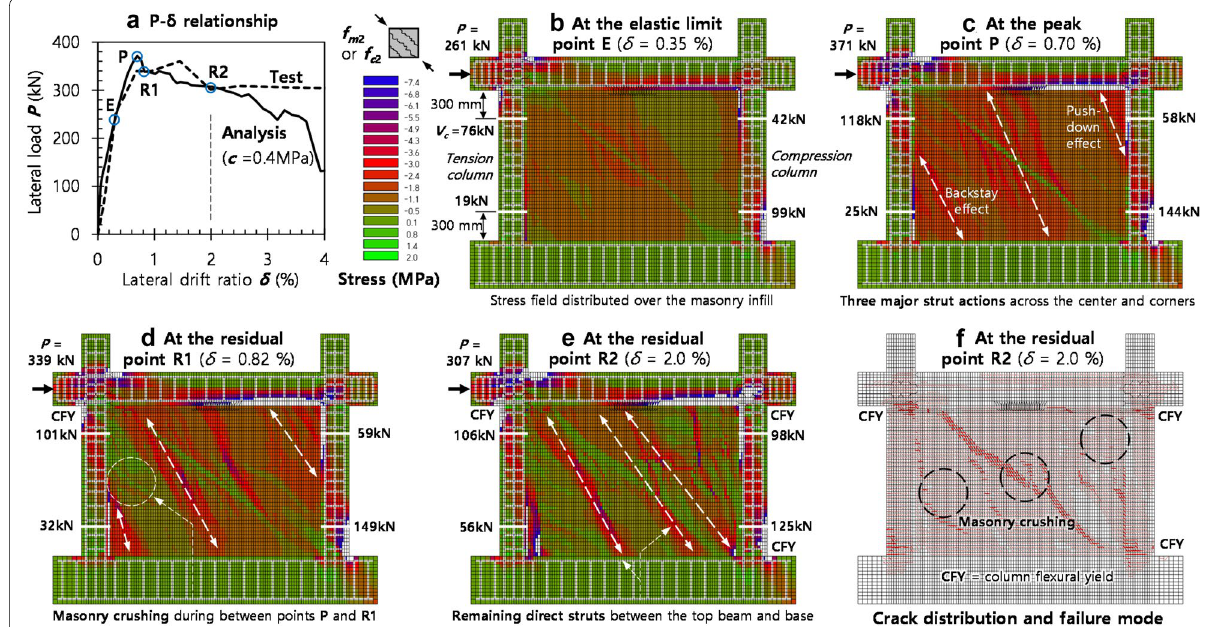
Fig. 6 Variation of stress distribution and force transfer with deformation: standard infilled frame IF0.5–weak masonry infill.